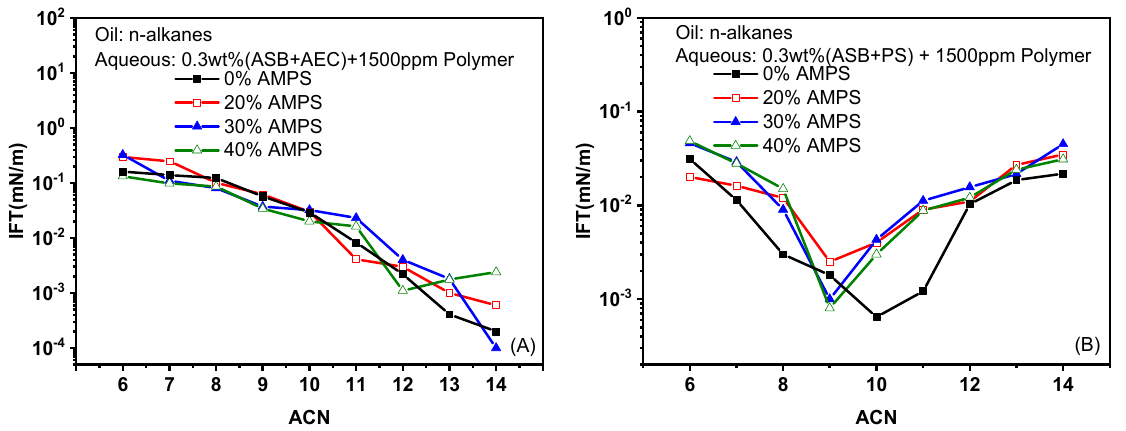
Figure 3. Effect of polymers on equilibrium IFT between 0.3 wt% ASB@AEC ( A ) and ASB@PS ( B ) solutions against n-alkanes.